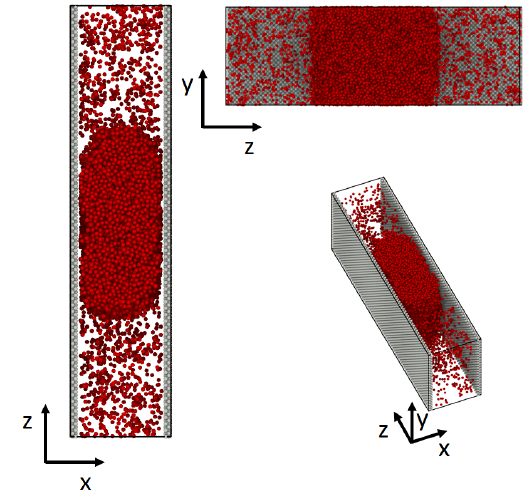
Figure 2. System used in the simulation. The droplet in the middle of the slit pore is surrounded by a vapor phase on both